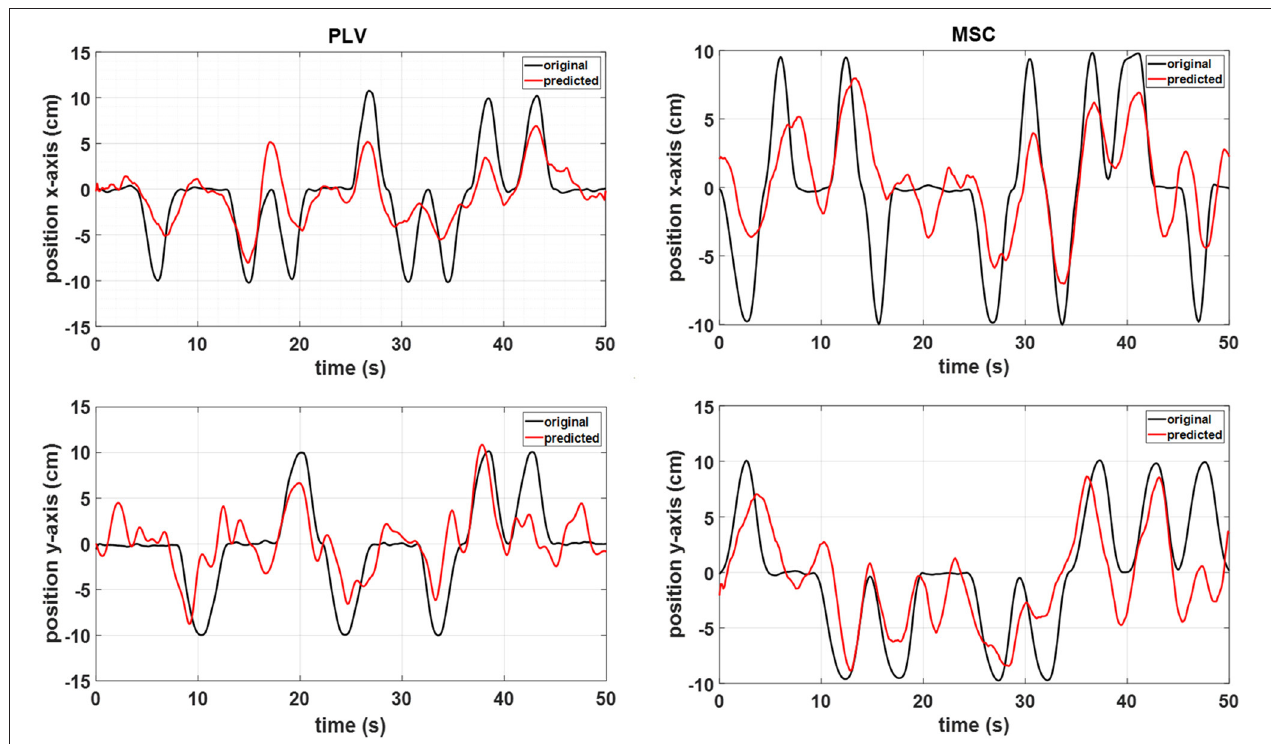
FIGURE 6 | A representative sample of the MLR reconstructed movement positions with the PLV features (left) and MSC features (right) from subject 6 data.